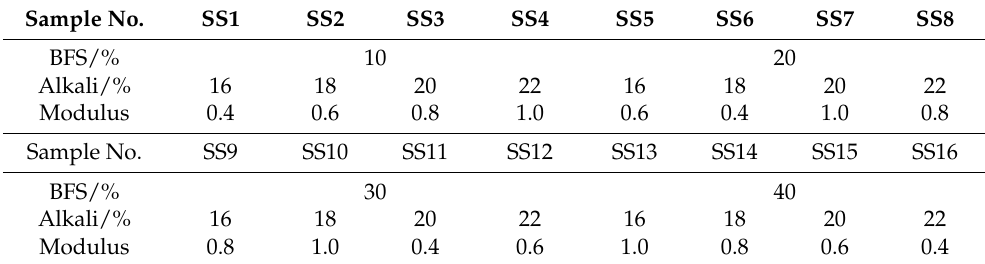
Table 5. Stage II: the second stage of mixture design. Sample No.